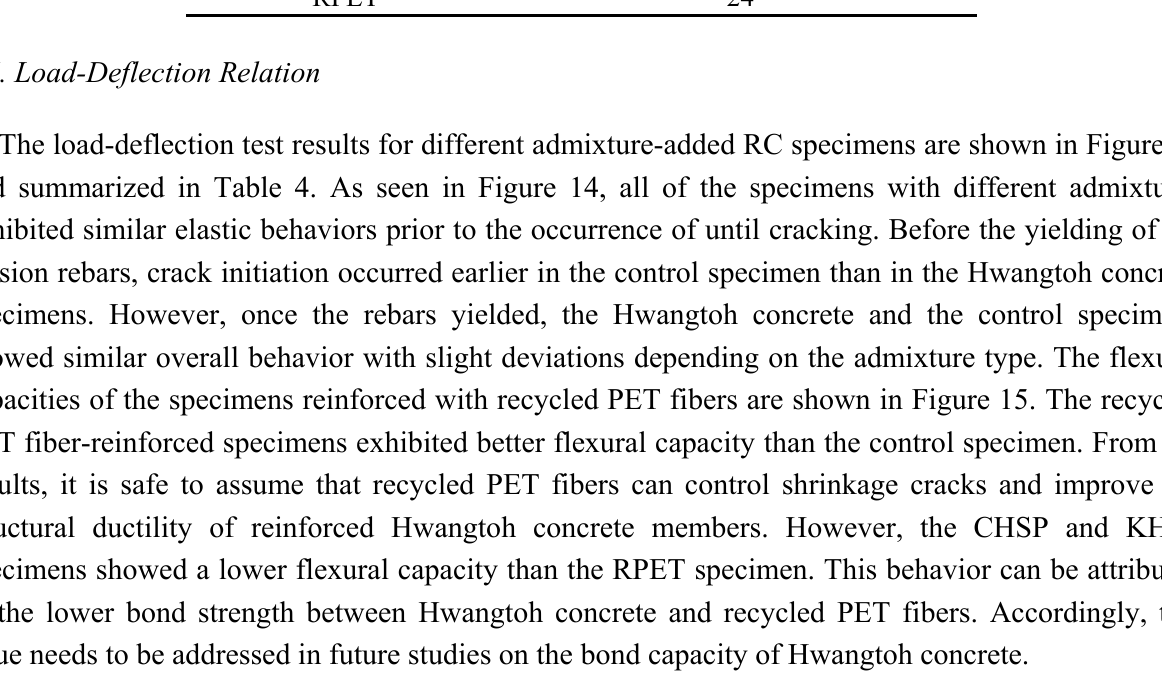
Table 4. Flexural strength test results for Hwangtoh concrete